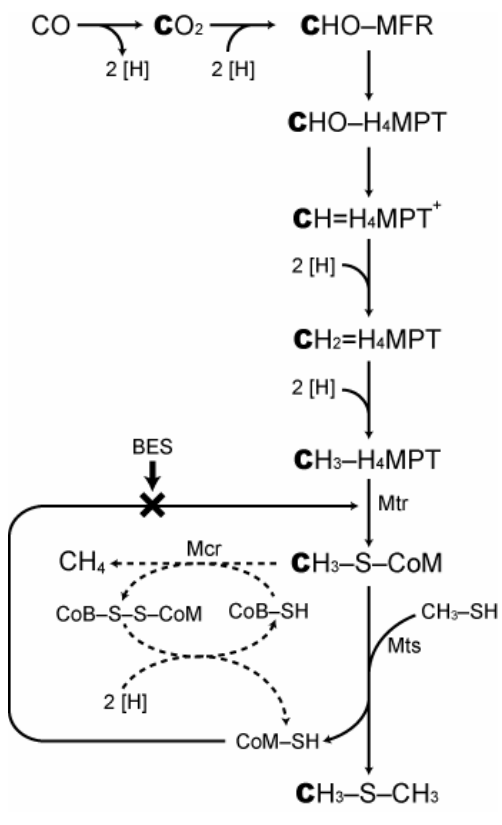
Fig. 5. A simplified scheme of methanogenic dimethyl sulfide (DMS) formation. The formation of DMS from carbon monox- ide (CO) is reported in Moran et al. (2008). The carbon atoms highlighted in bold type refer to the process proposed in this study, i.e., formation of DMS from CO 2 . The dashed arrows are path- ways that are bypassed when DMS rather than methane is pro- duced. The enzymatic step inhibited by 2-bromoethanesulfonic acid (BES) is marked with a cross. Abbreviations: MFR, methanofuran; H 4 MPT, tetrahydromethanopterin; CoM-SH, coenzyme M; CH 3 - S-CoM, methyl coenzyme M; CoB-SH, coenzyme B; Mtr, N 5 - methyl-H 4 MPT:CoM-SH methyltransferase; Mcr, methyl-CoM re- ductase; Mts, methylthiol:CoM